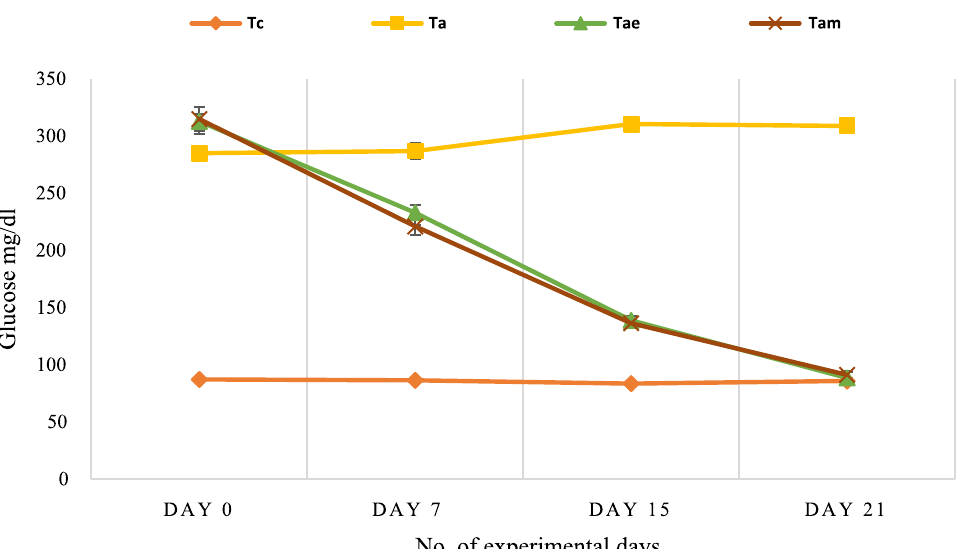
Fig. 2 Effect of mango peel extract and mangiferin on fasting plasma glucose levels in the alloxan-induced type I diabetic rat. In this figure shows that the Ta group has higher plasma glucose levels than the Tc group, Tae and Tam show a significant decrease in plasma glucose levels with the duration of days of